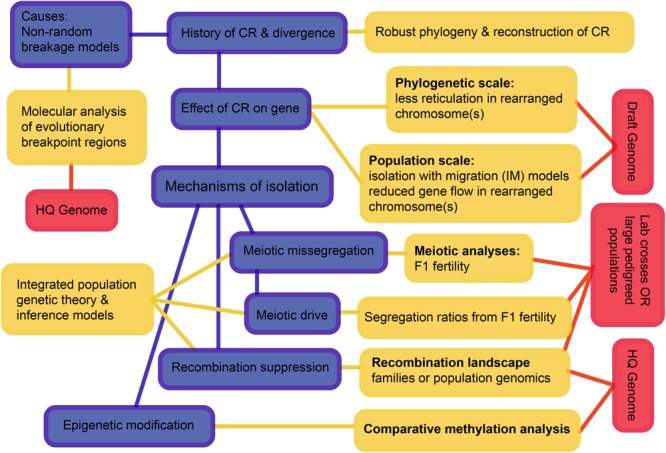
A schematic overview of an integrative approach to increase understanding how chromosomal rearrangements create divergence and speciation. The hierarchy outlined progresses from simple to complex and may not be feasible for all non-model systems, but outlines the ultimate goals. Blue boxes highlight the processes, yellow boxes highlight the analyses and red boxes highlight the data needed to achieve a holistic understanding of chromosomal speciation. CR, chromosome rearrangement; HQ, high quality.